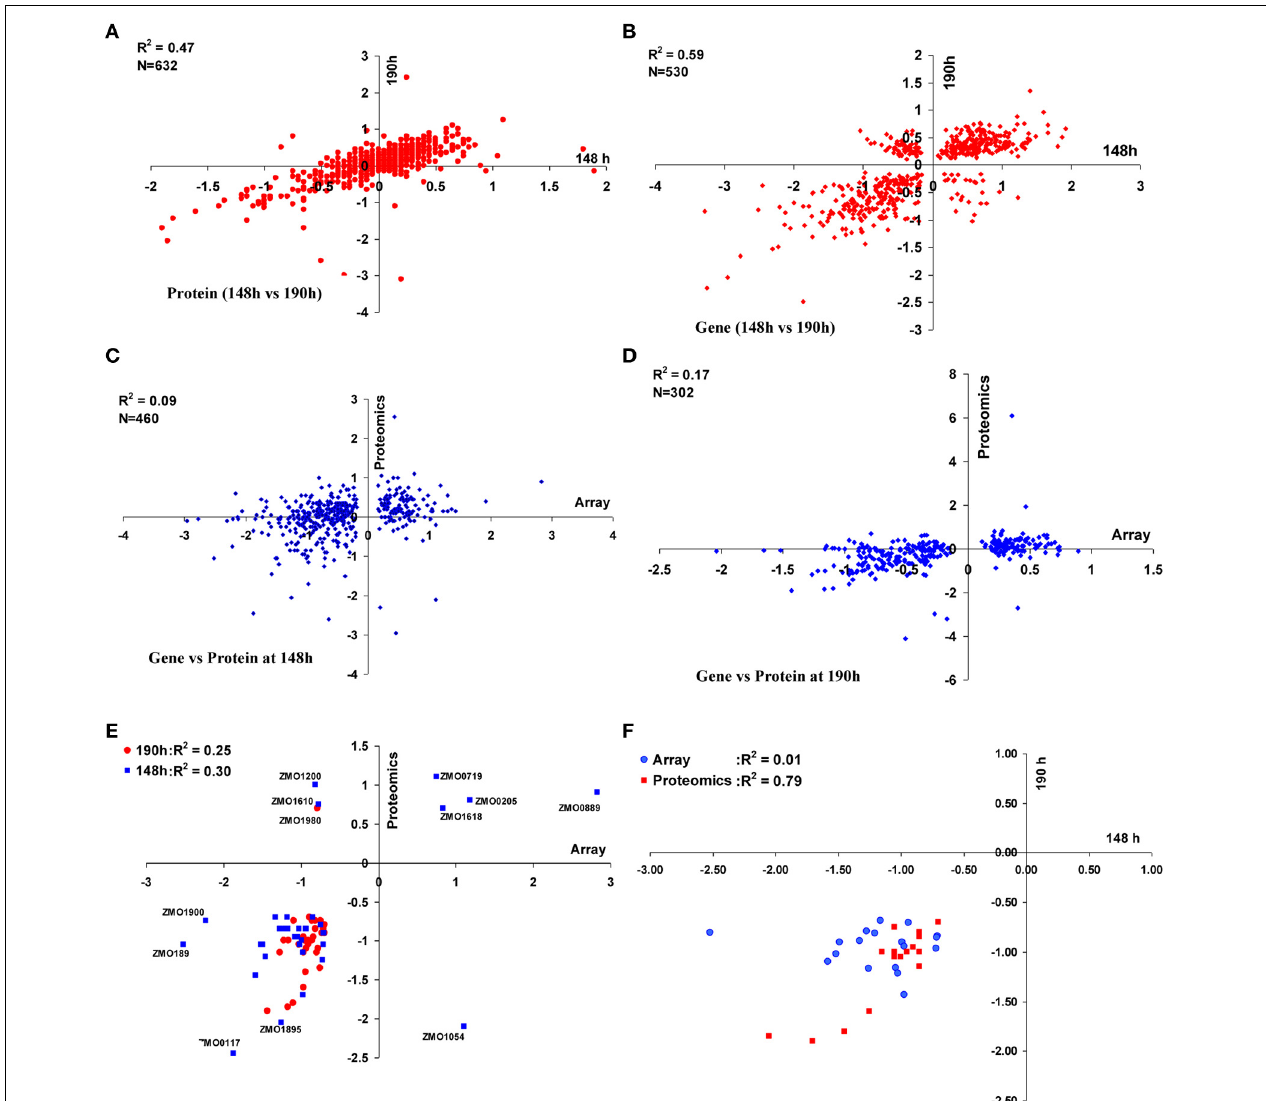
FIGURE 2 | Correlations between proteomic and transcriptomic data of ZM4 and AcR in MM. Correlation within proteomics or transcriptomics shared at time point of 148 and 190h between 632 proteins (A) or 530 genes (B) differentially expressed between AcR and ZM4 (AcR/ZM4) in MM; and the correlation between proteomics or transcriptomics at different time points of 148h (C) or 190h (D)